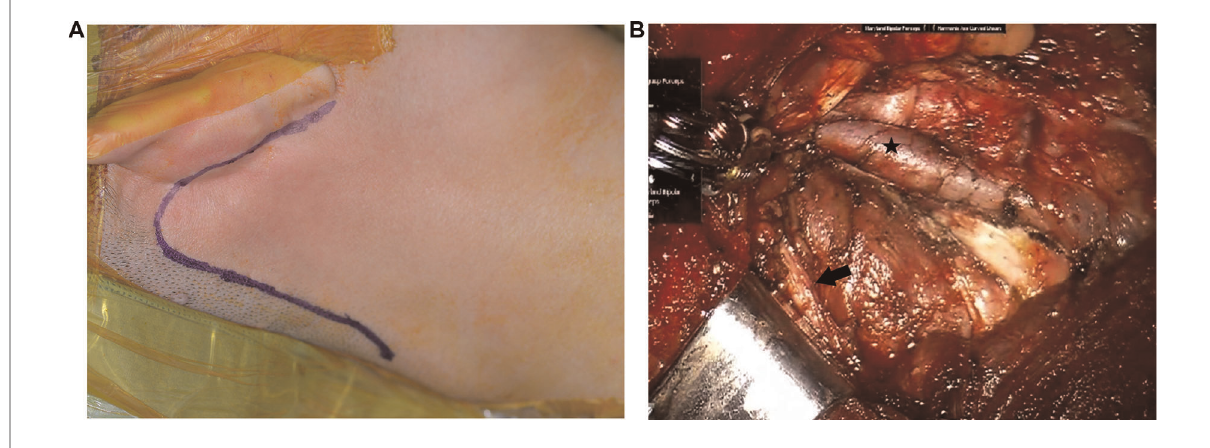
FIGURE 2 Transoral robotic selective neck dissection with a postauricular incision. ( A ) An additional postauricular incision is made. ( B ) Surgical view after dissection of level II. Black star: internal jugular vein, black arrow: spinal accessory